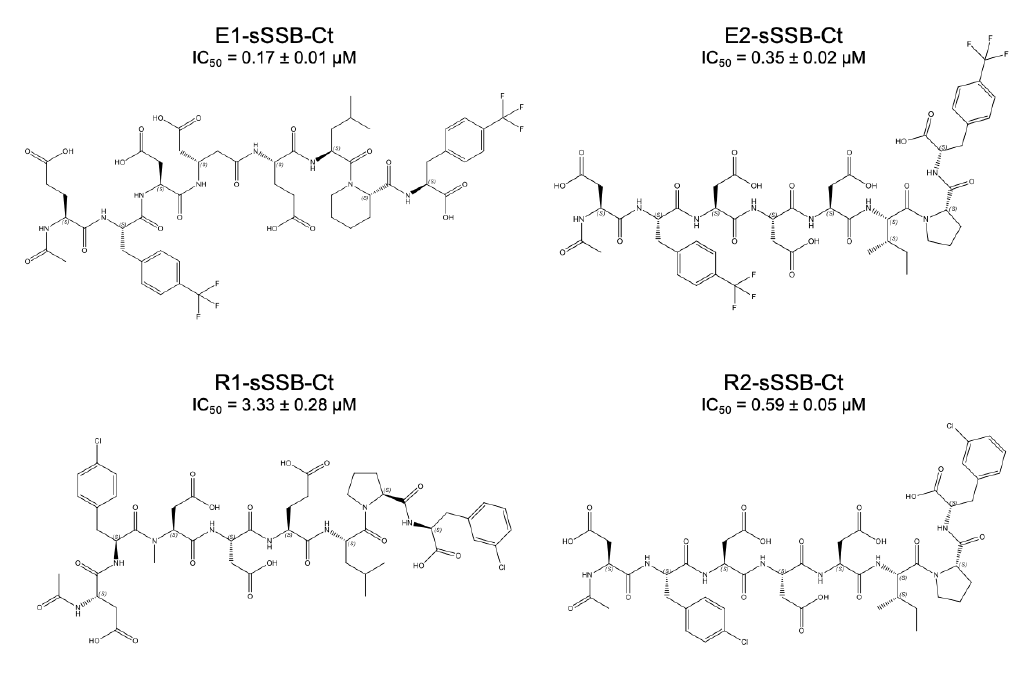
Figure 6. Combined modifications of wtSSB-Ct. E1-sSSB-Ct and E2-sSSB-Ct were tested on Exol. R1-sSSB-Ct and R2-sSSB-Ct were tested on RecO. IC 50 values show the ability of the sequences to compete effectively with F-wtSSB-Ct in a competitive fluorescence anisotropy assay.